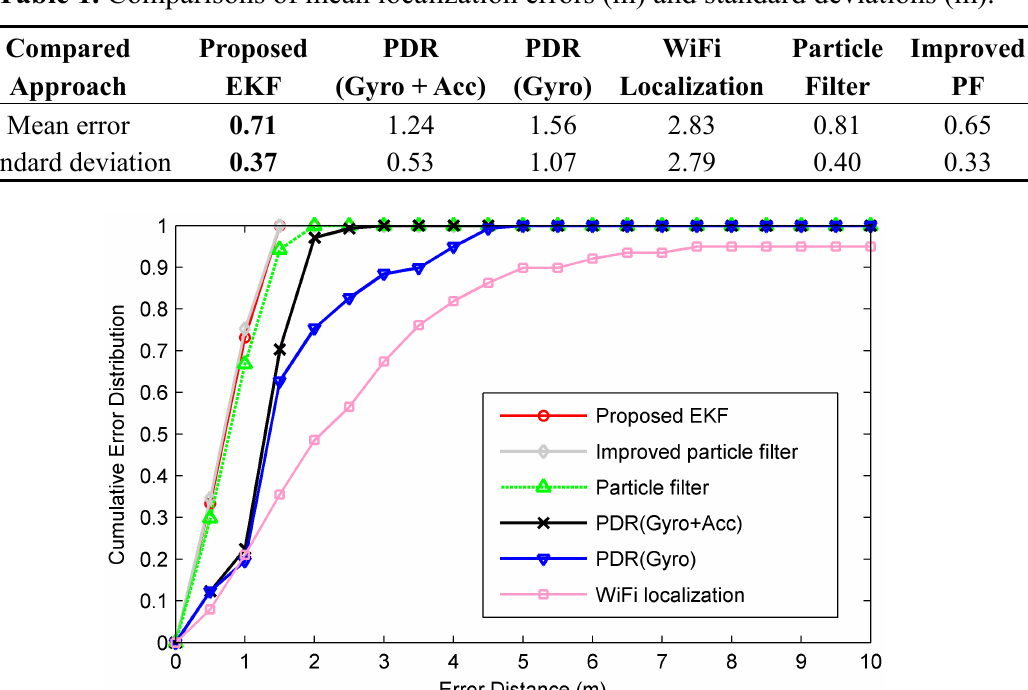
Table 1. Comparisons of mean localization errors (m) and standard deviations (m).